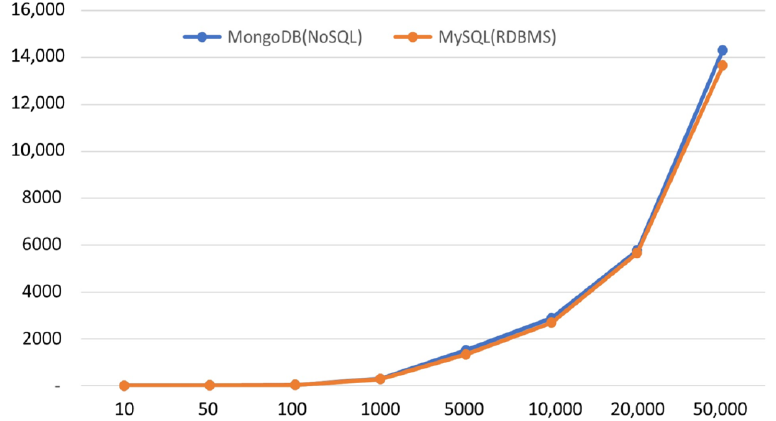
Figure 12. Results of read performance experiment ( x -axis: number of data points, y -axis: read speed in ms).